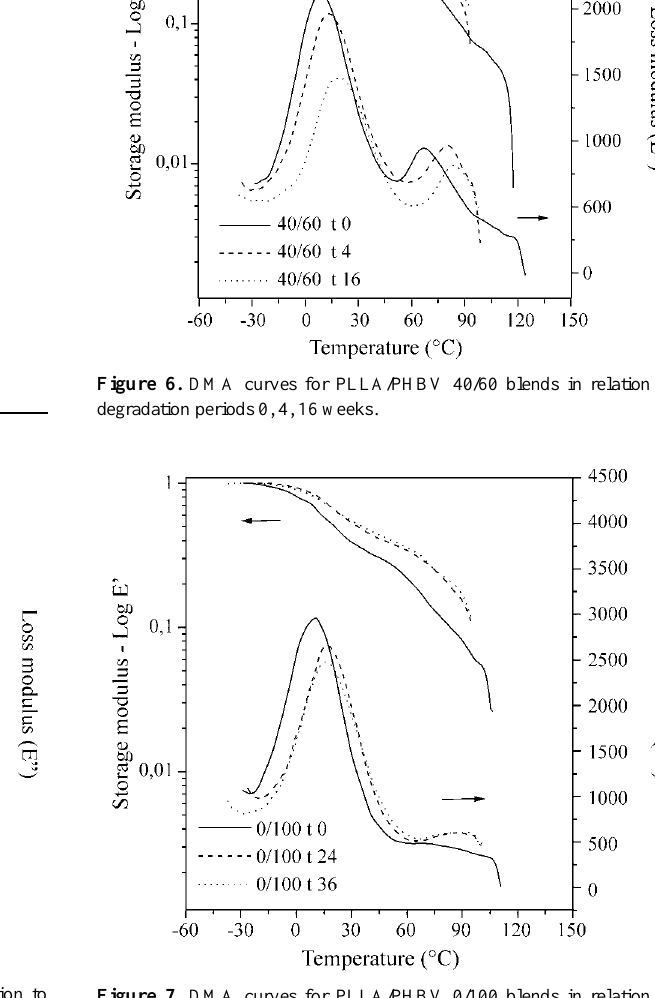
Figure 7. DMA curves for PLLA/PHBV 0/100 blends in relation to degradation periods 0, 24, 36 weeks.